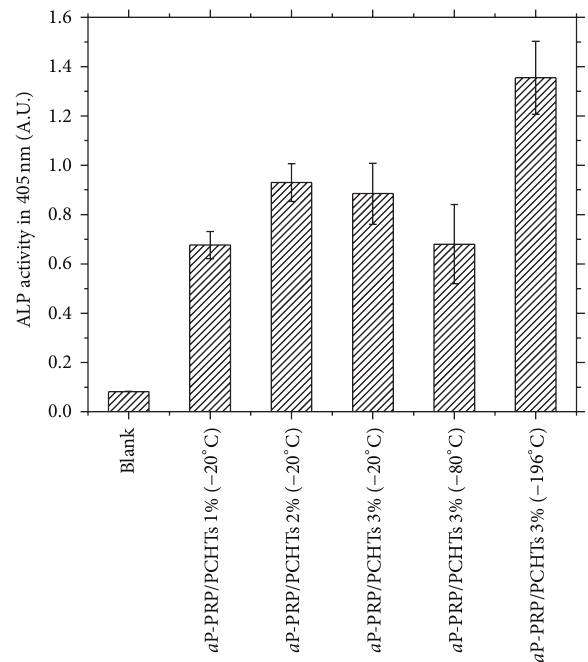
Figure 7: ALP activities of cells cultured on 𝑎 P-PRP/PCHTs scaffolds prepared with different CHT concentrations and freezing conditions (statistically significant differences from blank, 𝑛 = 3 , ∗ 𝑃 < 0.05 ). Blank = the reagents used in the assay only. The concentration of platelets in whole blood donors (average of 2 donors) was 163,500 pq/mm 3 . After preparation of the PRP, the platelets were concentrated approximately 1.74 times, with an average final concentration of 303,000 pq/mm 3